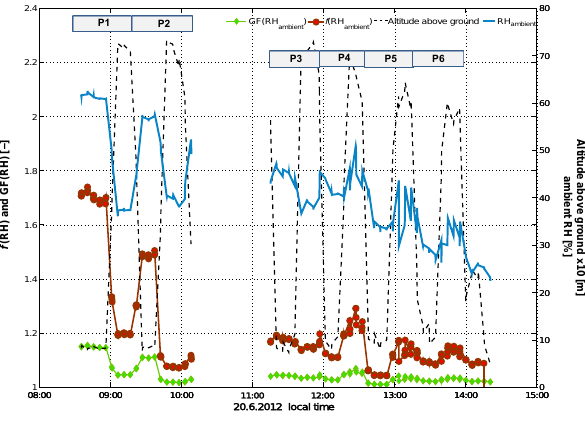
Figure 6. Time series of hygroscopic properties and ambient RH. The blue line illustrates the ambient RH during the flight (right y axis). The green diamonds show the growth factor (GF) for the ambient RH calculated from GF(RH = 95%) measurements for 500nm particles with the WHOPS. The red line shows the scatter- ing enhancement factor ( f (RH)) during the flight as derived from the ambient RH and the GF measurements. The uncertainty of the airborne f (RH) amounts to approximately 30%, while the GF val- ues are expected to have uncertainties <